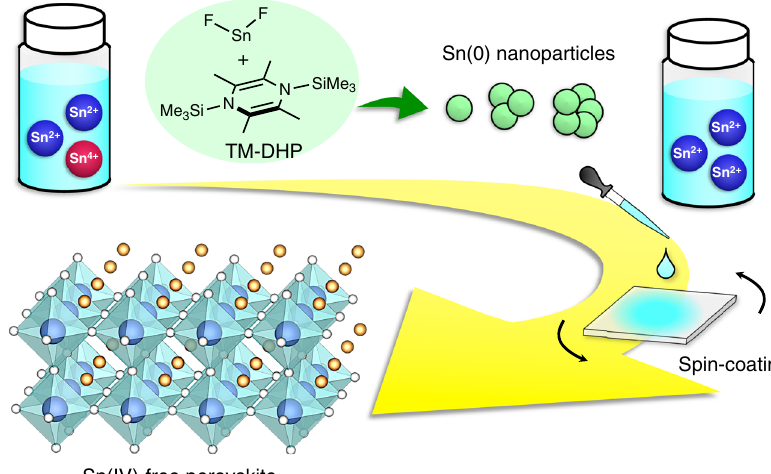
Fig. 1 Schematic illustration of the Sn(IV) scavenging method. 1,4-Bis(trimethylsilyl)-2,3,5,6-tetramethyl-1,4-dihydropyrazine (TM-DHP) is added to the tin perovskite precursor solution. Sn(0) nanoparticles formed by the reduction of SnF 2 by TM-DHP scavenge residual